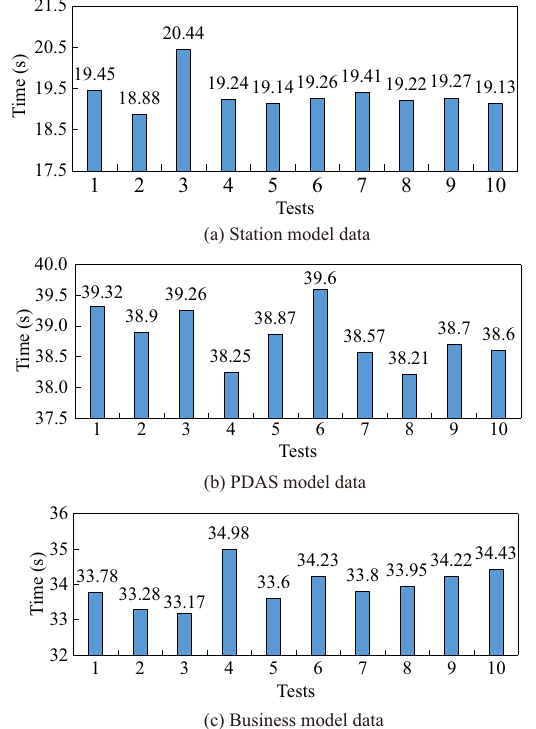
Fig. 11 Time for writing station model data.